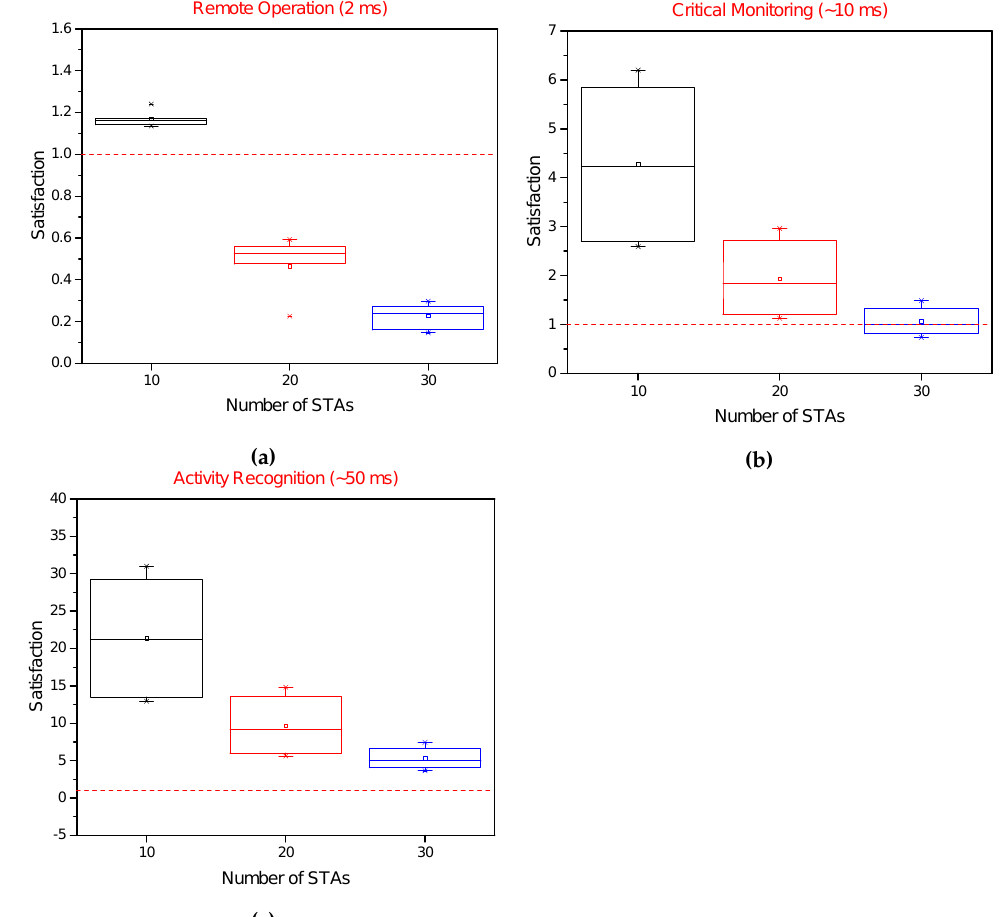
Figure 8. Satisfaction level of the proposed OFDMA scheduler in terms of delay for three different application classes in H-IoT. The red line at 1 depicts the threshold value for meeting the satisfaction levels of different applications. ( a ) Remote control applications with haptic control. ( b ) Critical monitoring of health parameters in real-time. ( c ) Activity recognition using real-time